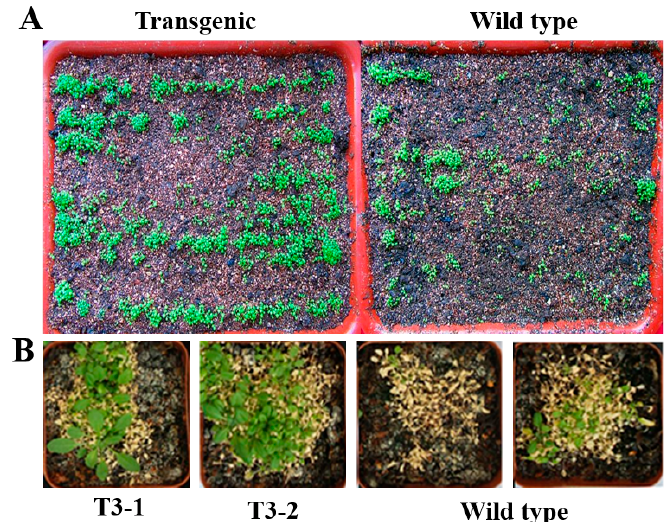
Figure 7. Low temperature resistance in wild type and transgenic plants. ( A ) The seven days old CpLEA5 gene-carrying Arabidopsis line T3-2 and wild type cultured at 4 °C environment for three weeks; ( B ) The seven days old CpLEA5 gene-carrying Arabidopsis line T3-2, T3-2 and wild type cultured at 4 °C environment for six weeks.